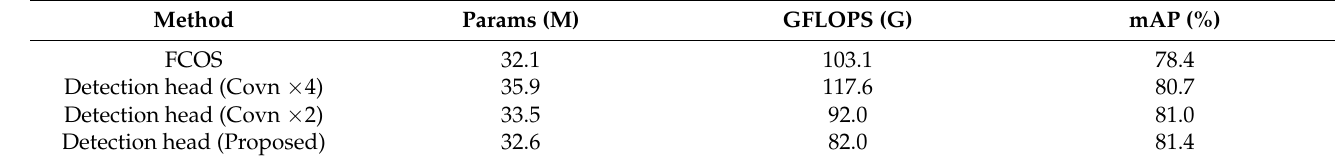
Table 5. Ablation study for detection head analysis on the PASCAL VOC 2007 test